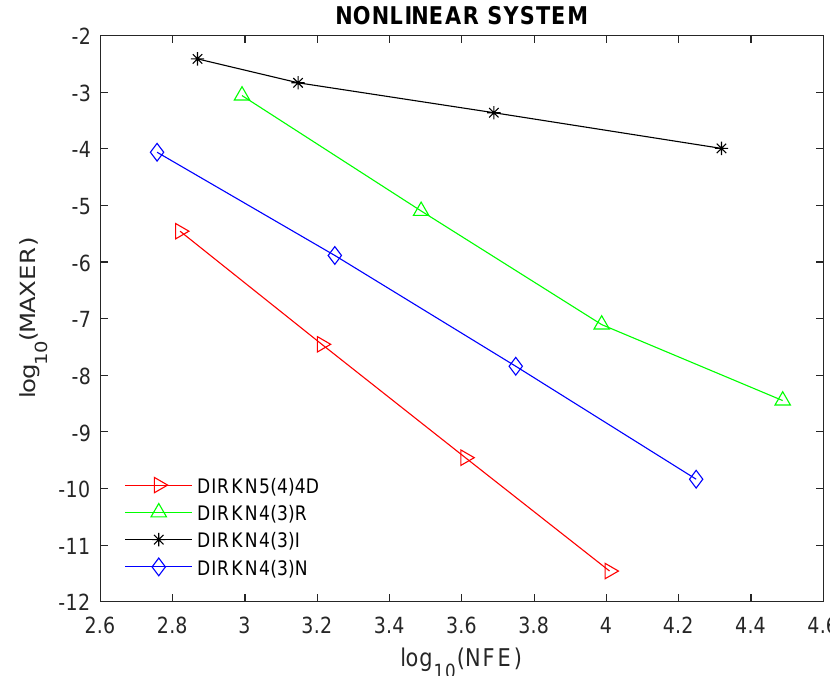
Figure 3. Efficiency curves for Example